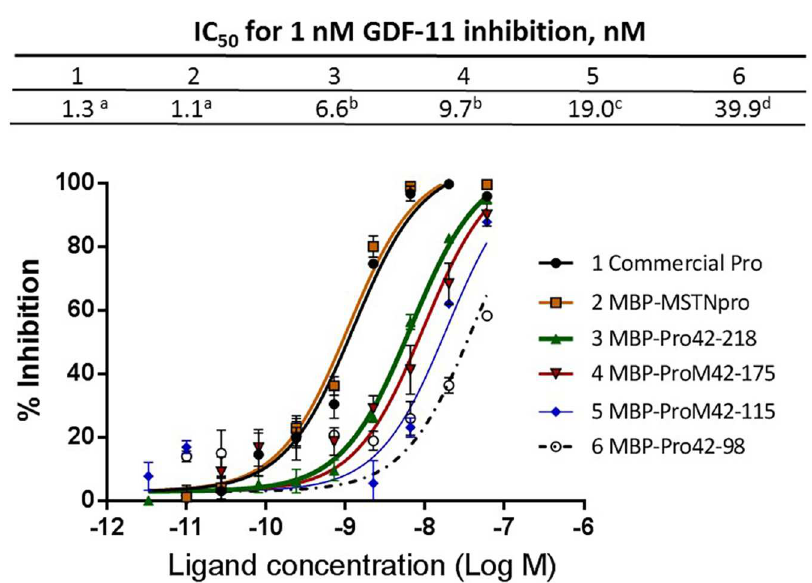
Fig 4. Inhibition of GDF-11 activity by MBP-pMSTNpro proteins. The assay procedurewas the same as the MSTN inhibitionassay (Fig 3) except that GDF-11 was used as a competing ligandinstead of MSTN. Error bars represent ± SEM (n = 6). The means of IC 50 not sharingthe same superscript are different at P <